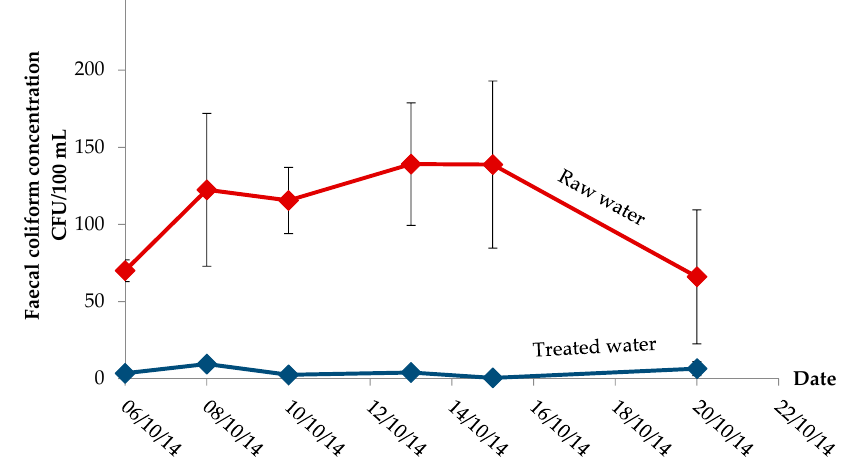
Figure 5. Faecal coliform concentrations in raw and treated water during October 2014.